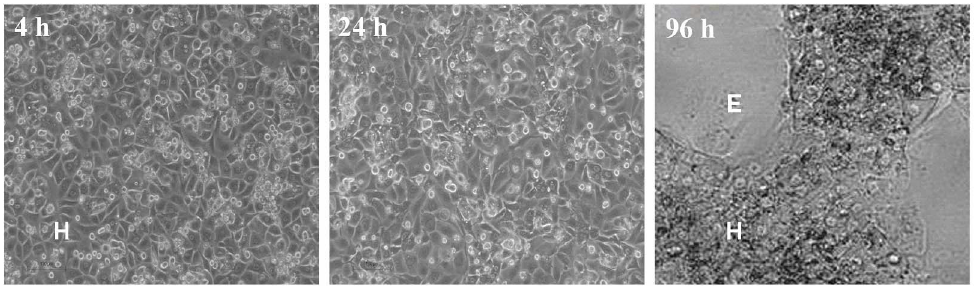
Figure 2. Phase-contrast image of HepaRG cells 4 h, 24 h and 96 h after seeding. H, hepatocyte-like cells; E, biliary epithelial-like cells. doi:10.1371/journal.pone.0059432.g002 PLOS ONE |